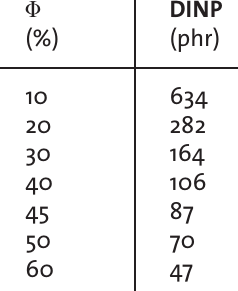
Figure 3: SEM observations of resin A and B (a: Medium particles of resin A, b: Large particles of resin B, c: Small particles of resin A). Table 1: Correspondence between F, the volume fraction of PVC and concentration of DINP expressed in parts per hun- dred of resin